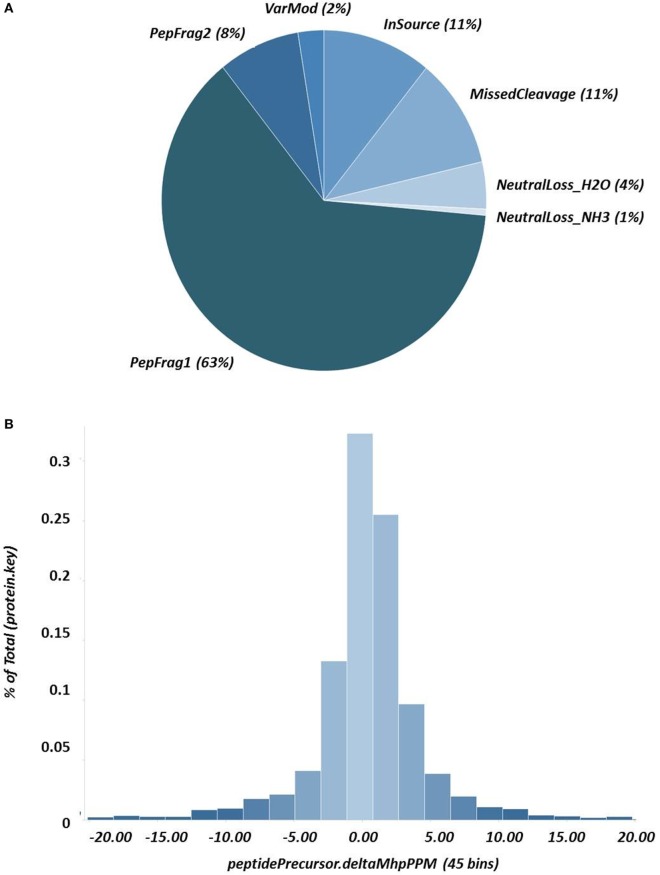
Results of nanoUPLC HDMSE analysis showing (A) the peptide-match distribution to ascertain the quality of fragmentation and digestion; and (B) the distribution of fragment masses and the exact mass accuracy for the precursor ions ± 10 ppm.